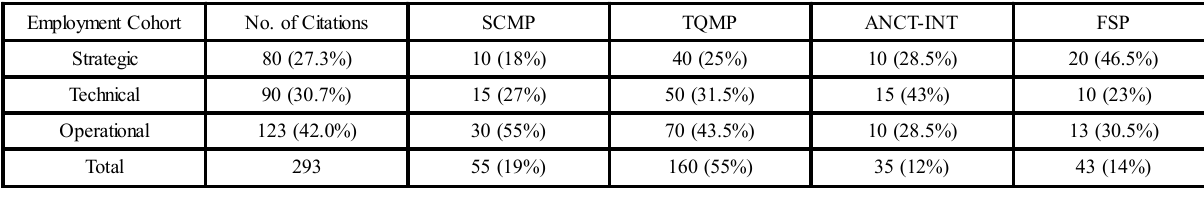
TABLE 2. EMPLOYMENT COHORT WITH RESPECT TO THEIR CITATIONS DETAIL